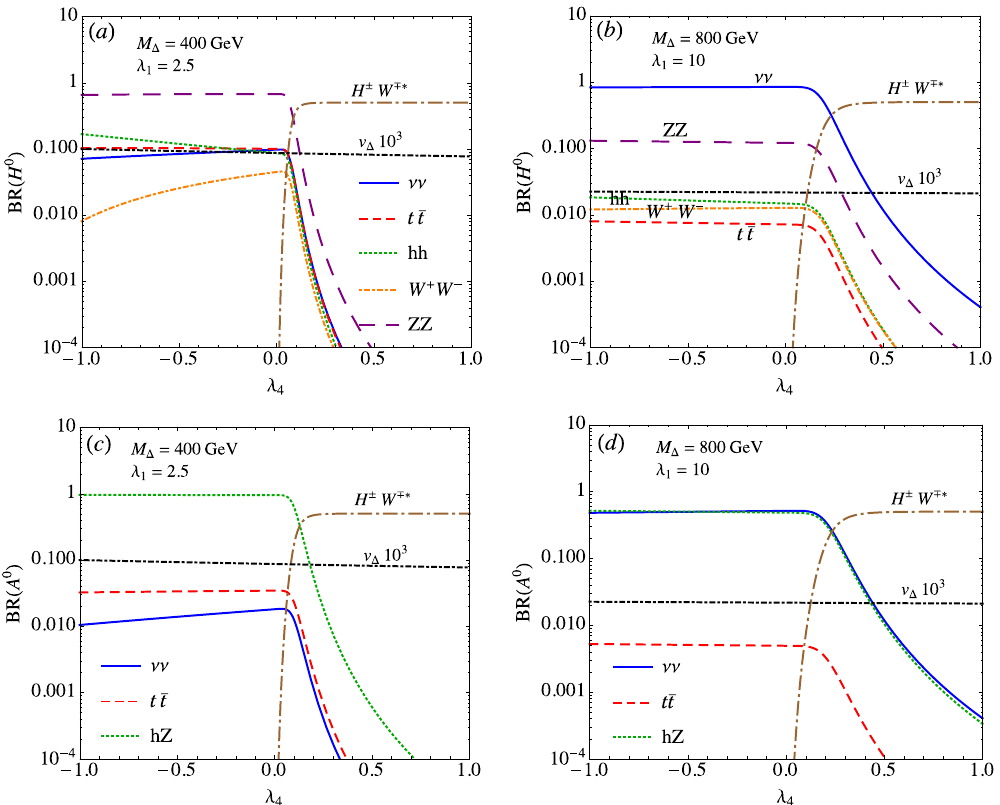
Figure 14 . This legend is the same as that shown in (cid:12)gure 11, where plots (a) and (b) are for H 0 decays, and plots (c) and (d) are for A 0 decays.